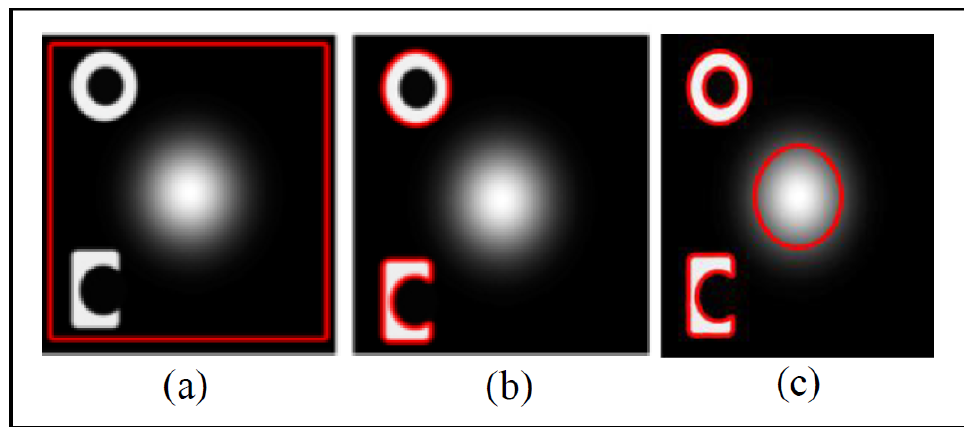
Figure 4. Segmentation result on a synthetic image based on GAC model; ( a ) the initial contour shown in red color, ( b ) the final segmentation result, and ( c ) shows all of the boundaries that should be